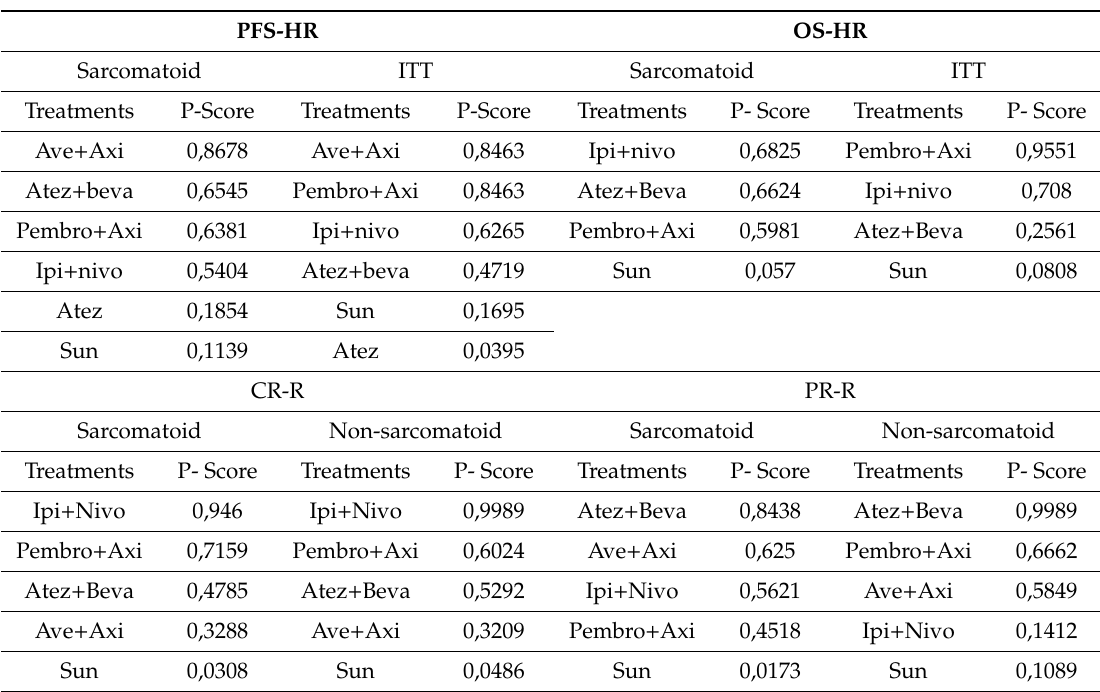
Table 2. Results of the network meta-analysis. Anti PD-1 / PDL-1 agents are ranked from best to worse according to the di ff erent e ffi cacy end points considered. PFS-HR OS-HR Sarcomatoid ITT Sarcomatoid